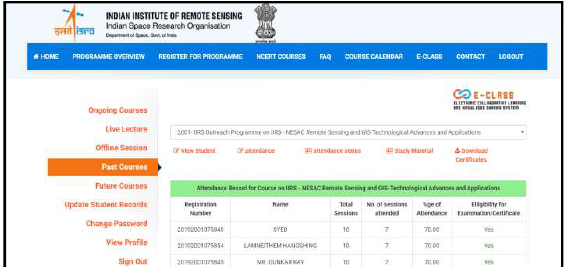
Figure 7. Attendance Marked for all participants of